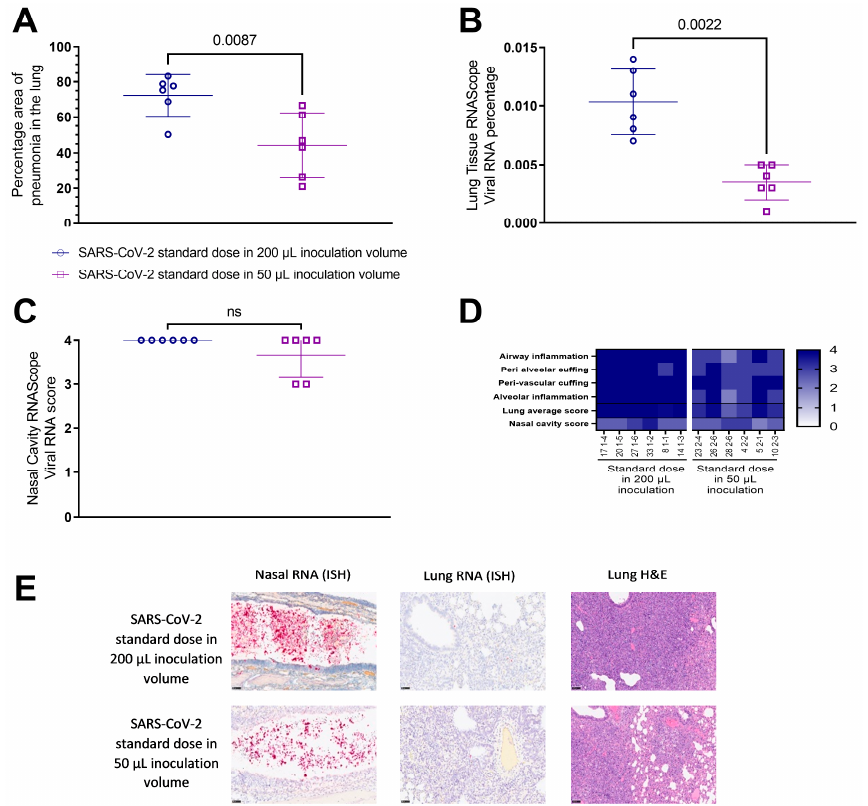
Figure 2. Histopathological findings in the lung and nasal cavity of hamsters challenged with SARS-CoV-2 delivered in varied inoculum volumes 7 days post infection. ( A ) Percentage of areas of pneumonia in the lung determined by image analysis (Nikon-NIS-Ar). ( B ) Percentage of lung positively stained against SARS-CoV-2 RNA measured by in situ-hybridisation (ISH). ( C ) Subjective scores of presence of SARS-CoV-2 RNA in the nasal cavity measured by ISH. ( D ) Heatmap to illustrate severity of histopathological changes in the lung. ( E ) Representative images of viral RNA in the nasal cavity ( left panels) and lung ( centre panels) and lung H&E ( right panels). Statistical differences measured by Mann-Whitney.